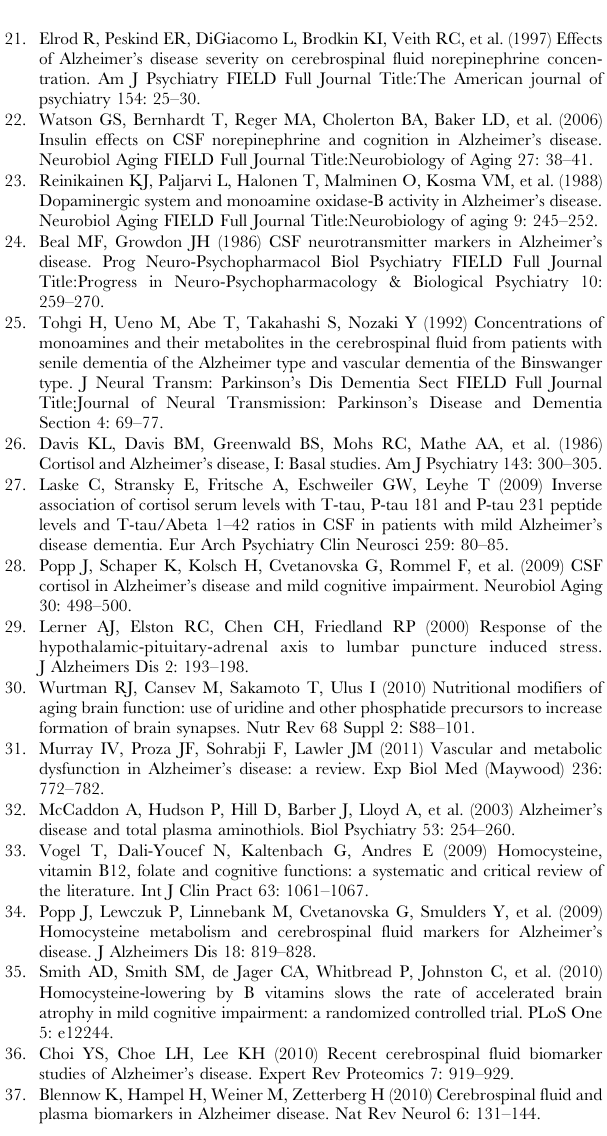
Table S1 Table of all structurally assigned metabolites with their relative change in the different groups shown as Fold difference between the groups and the results of the statistical analysis of each data set showing the p-value. Table S2 The table S2 shows the results as mean of the group values of the metabolites measured in CSF with absolute quantification. All values are in